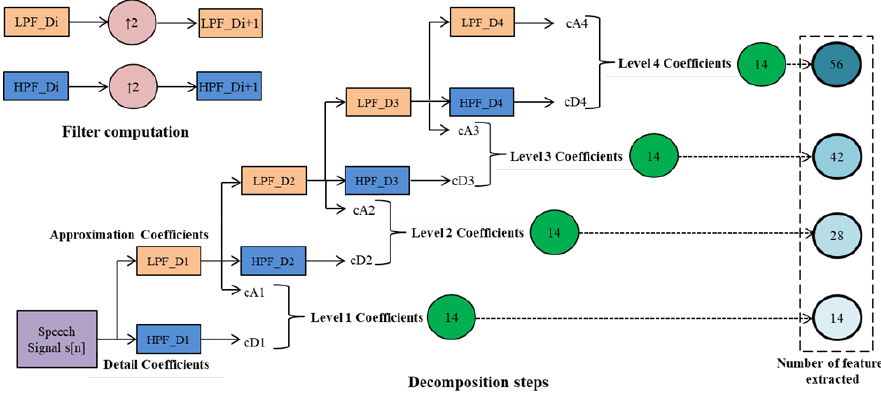
Figure 5. A four-stage decomposition.